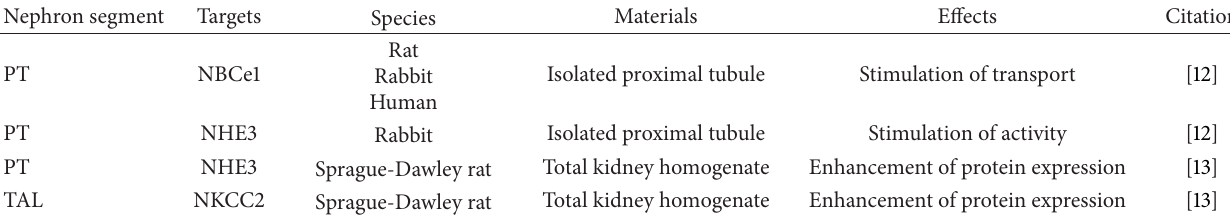
Table 1: The proposed targets and effects of TZDs in PT and TAL.